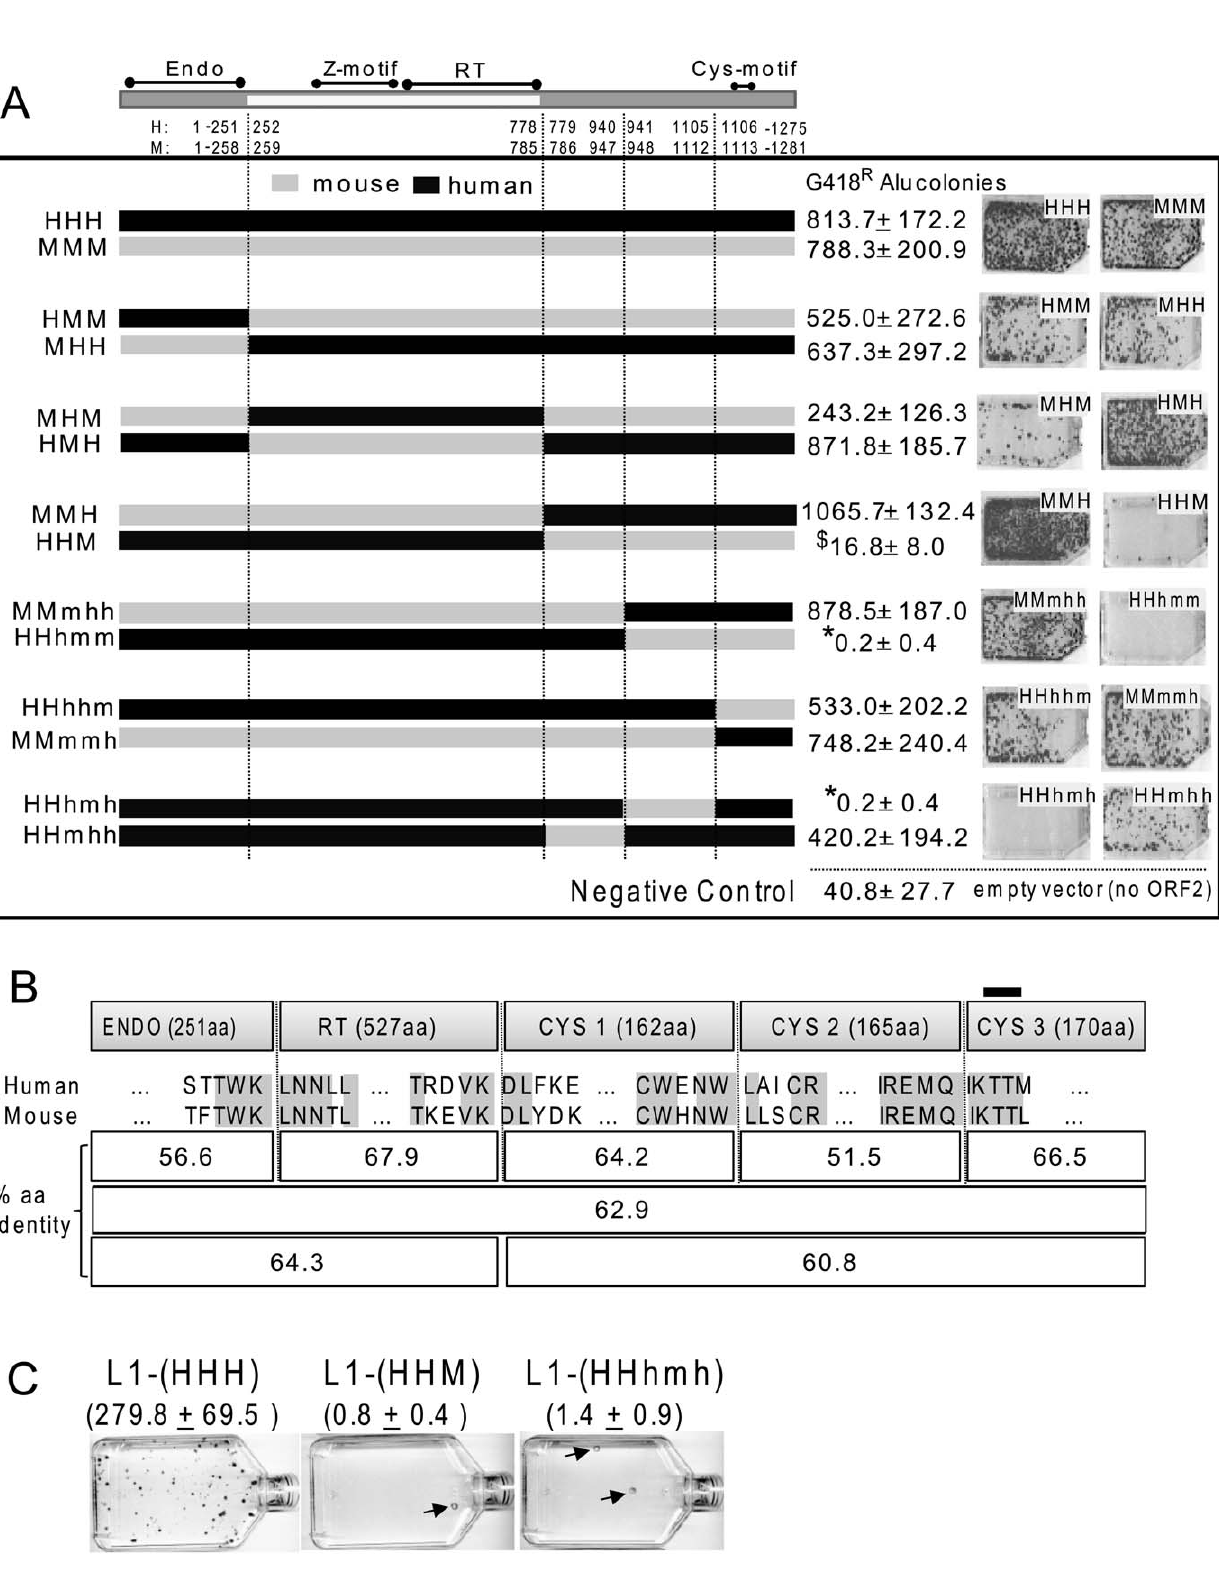
Figure 3. L1 ORF2p human-mouse chimera. A. Chimera breakpoint schematic of chimeric ORF2s and their ability to drive Alu retrotransposition intrans . A schematic for the L1 ORF2 protein with its three recognized domains, endonuclease (endo), reverse transcriptase (RT) and the ill-defined 3 9 region containing the cysteine-rich motif (cys), subdivided into three parts. The amino acid positions flanking the selected break points are indicated for human and mouse ORF2s. The constructs are named using 3 capital letters, each representing a domain: H for human and M for the mouse portions, where HHH and MMM represent complete human and mouse ORF2 proteins, respectively. In constructs where the cys- domain was further subdivided, the third capital H or M was replaced with three lowercase h or m letters, indicating the subdivision of the cys-